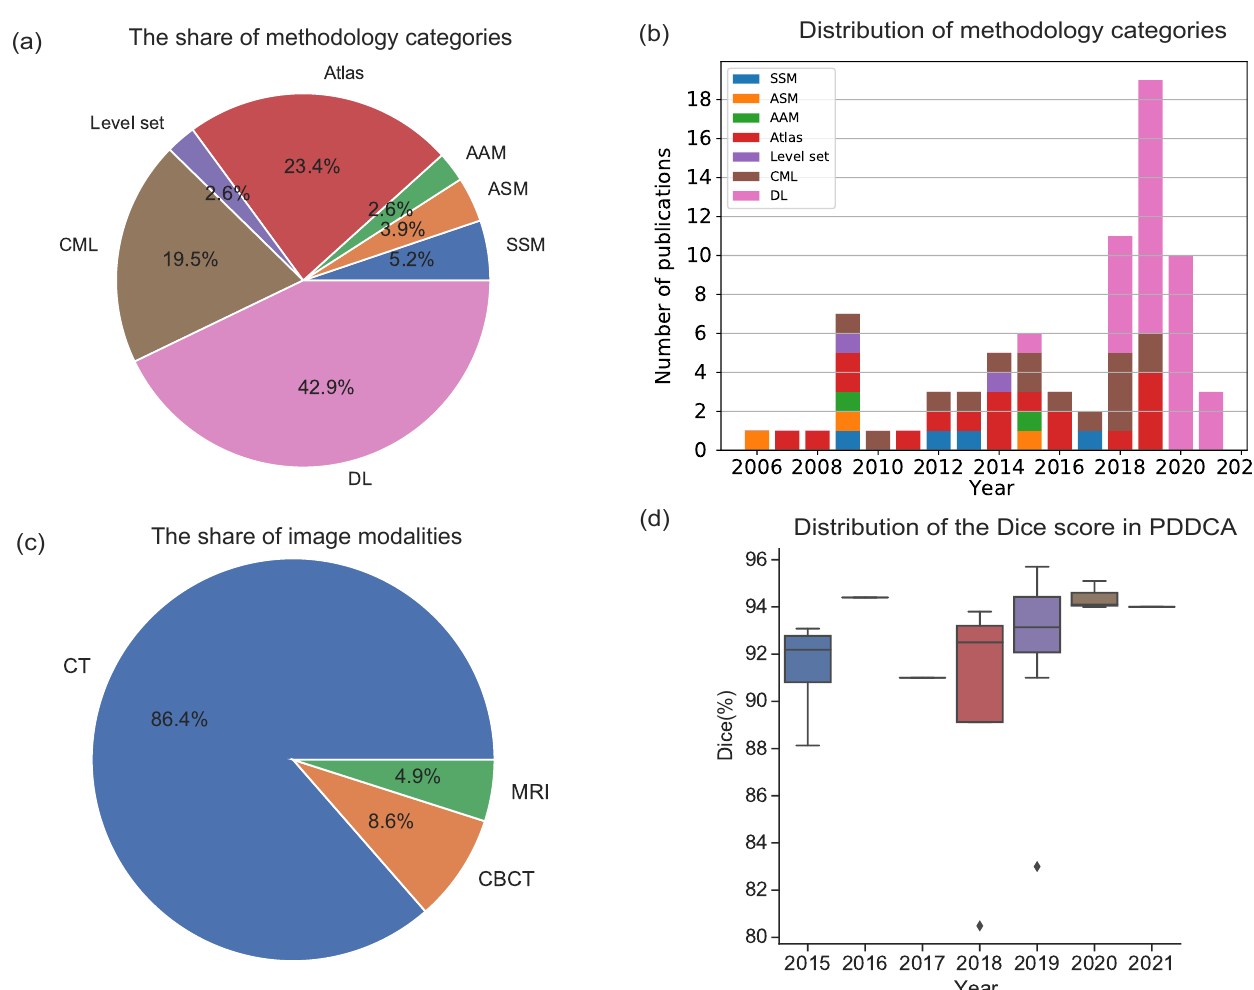
Figure 3. Analysis of publications pertaining to mandible segmentation. ( a ) The share of methodology categories used in the publications. ( b ) Distribution of the publications by year. ( c ) The share of image methodologies used in the publications. ( d ) Box plot of the distribution of the Dice score of the PDDCA test from the publications. The black lines in the middle of the box indicate the average Dice